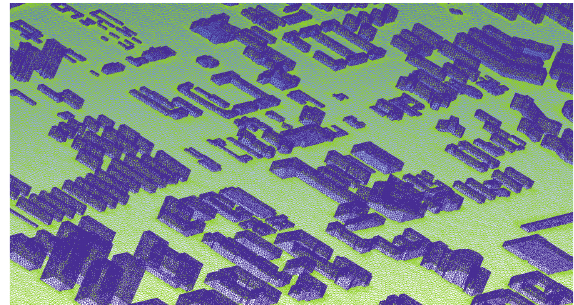
Figure 10: The grids of the original model.